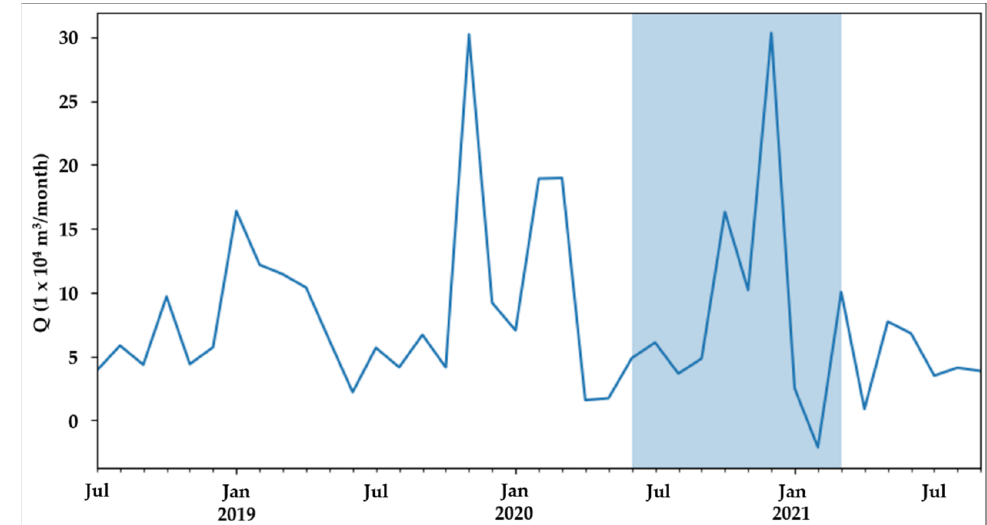
Figure 5. Monthly longshore drift during the monitoring period (positive values indicate southward drift) The highlighted blue region corresponds to the period covered by the pre- and post-nourishment TBS (June 2020 to March 2021). In the period covered by the pre- and post-nourishment TBS (June 2020 to March 2021) (highlighted blue region in Figure 5) the only reversal on longshore drift direction is observed in February 2021 in correspondence with persistency of westerly waves.